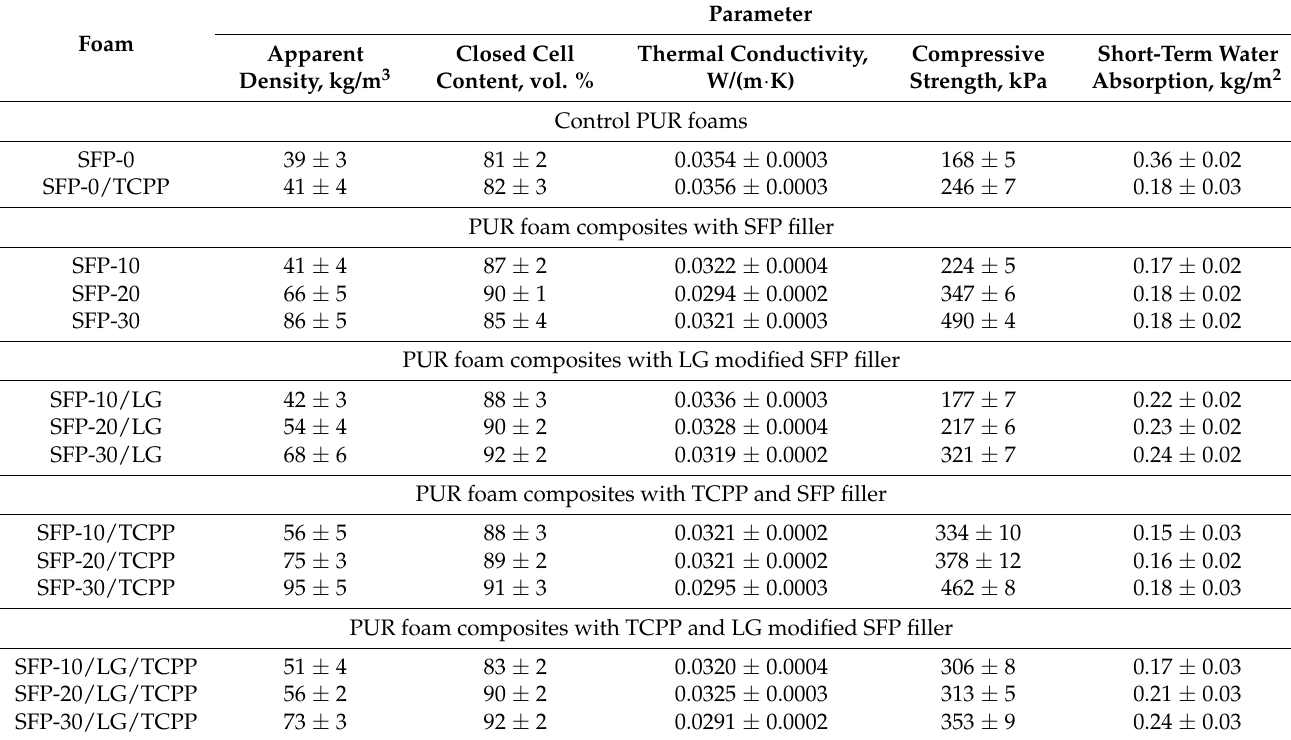
Table 2. Physical properties of control PUR foams and PUR foam